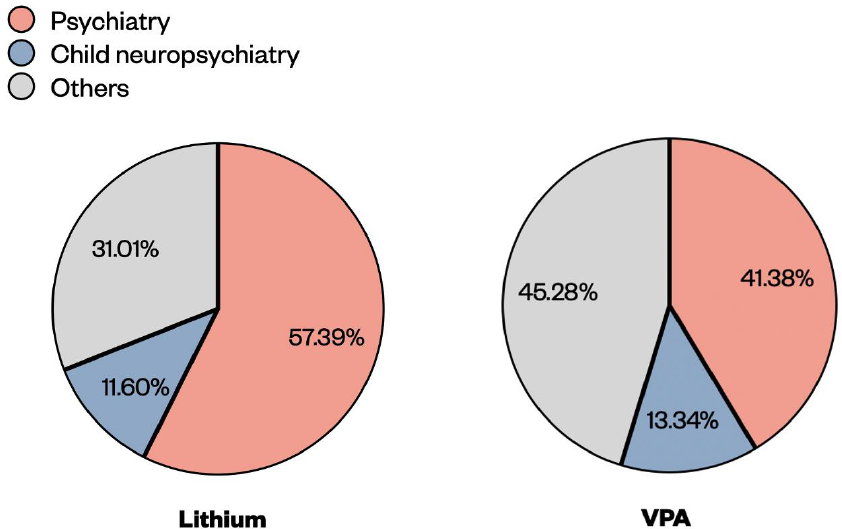
Figure 1. Percentages of lithium and VPA blood samples coming from different clinical units (psychi- atry, child neuropsychiatry and others) of the Hospital of the University of Pisa (Azienda Ospedaliero- Universitaria Pisana, AOUP) for the years 2016–2020. During the same period, a total of 12,294 VPA samples was registered, where 5087 (41.38%) came from the psychiatry unit, 1640 (13.34%) from child neuropsychiatry and the remaining 5567 (45.28%) came from other units (Figure 1). The median values of VPA Cp samples were stable across the years, with a Cp close to 50 µ g/mL (Table 1). We noticed that during 2020, the year when the COVID-19 pandemic spread across Italy and demanded several restrictions, the numbers of lithium and VPA samples decreased by 15–20% compared to other